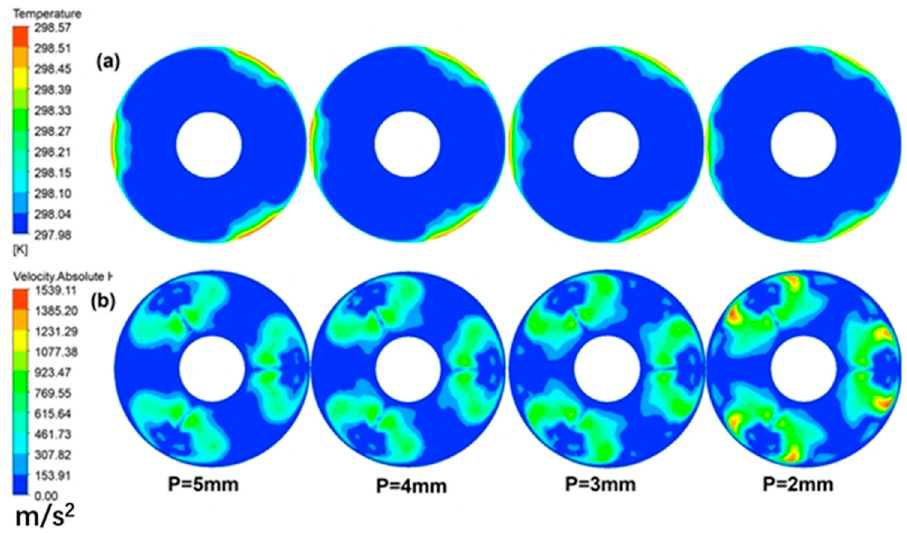
Figure 14. Temperature contour and helicity at Z = 61mm plane (P=2, 3, 4, 5 mm, N = 3, A = 30°, 𝑅𝑒 = 1200)